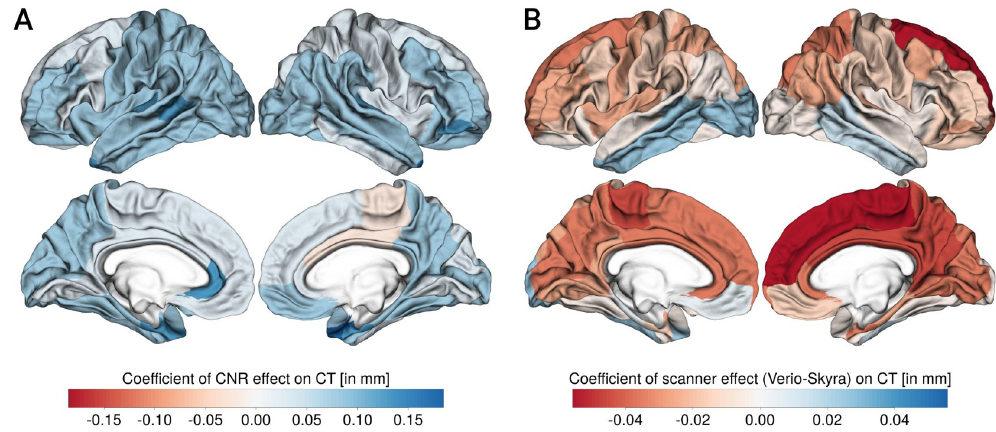
Fig 9. Association of CNR (A) and scanner (B, negative values indicate Skyra > Verio) with cortical thickness (CT), quantified as coefficients of a linear mixed model including both terms. Left column shows lateral and medial view of left hemisphere, right column shows lateral and medial view of right